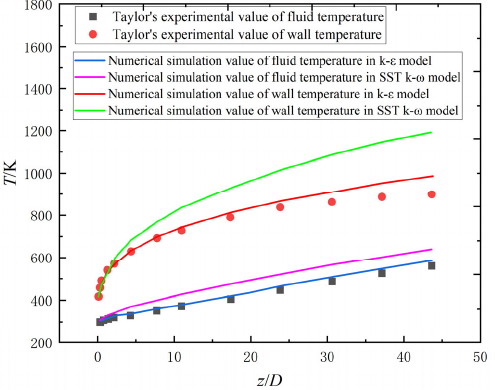
Figure 6. Numerical model validation by Chen et al. [19].